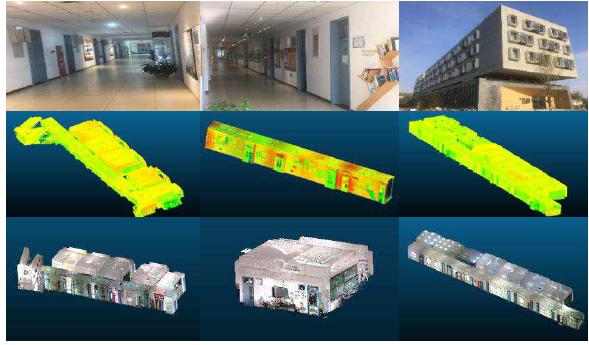
Figure 1. Dataset main scenarios （ Mainly divided into two parts :data set with reflection intensity information and data set without reflection intensity information ）